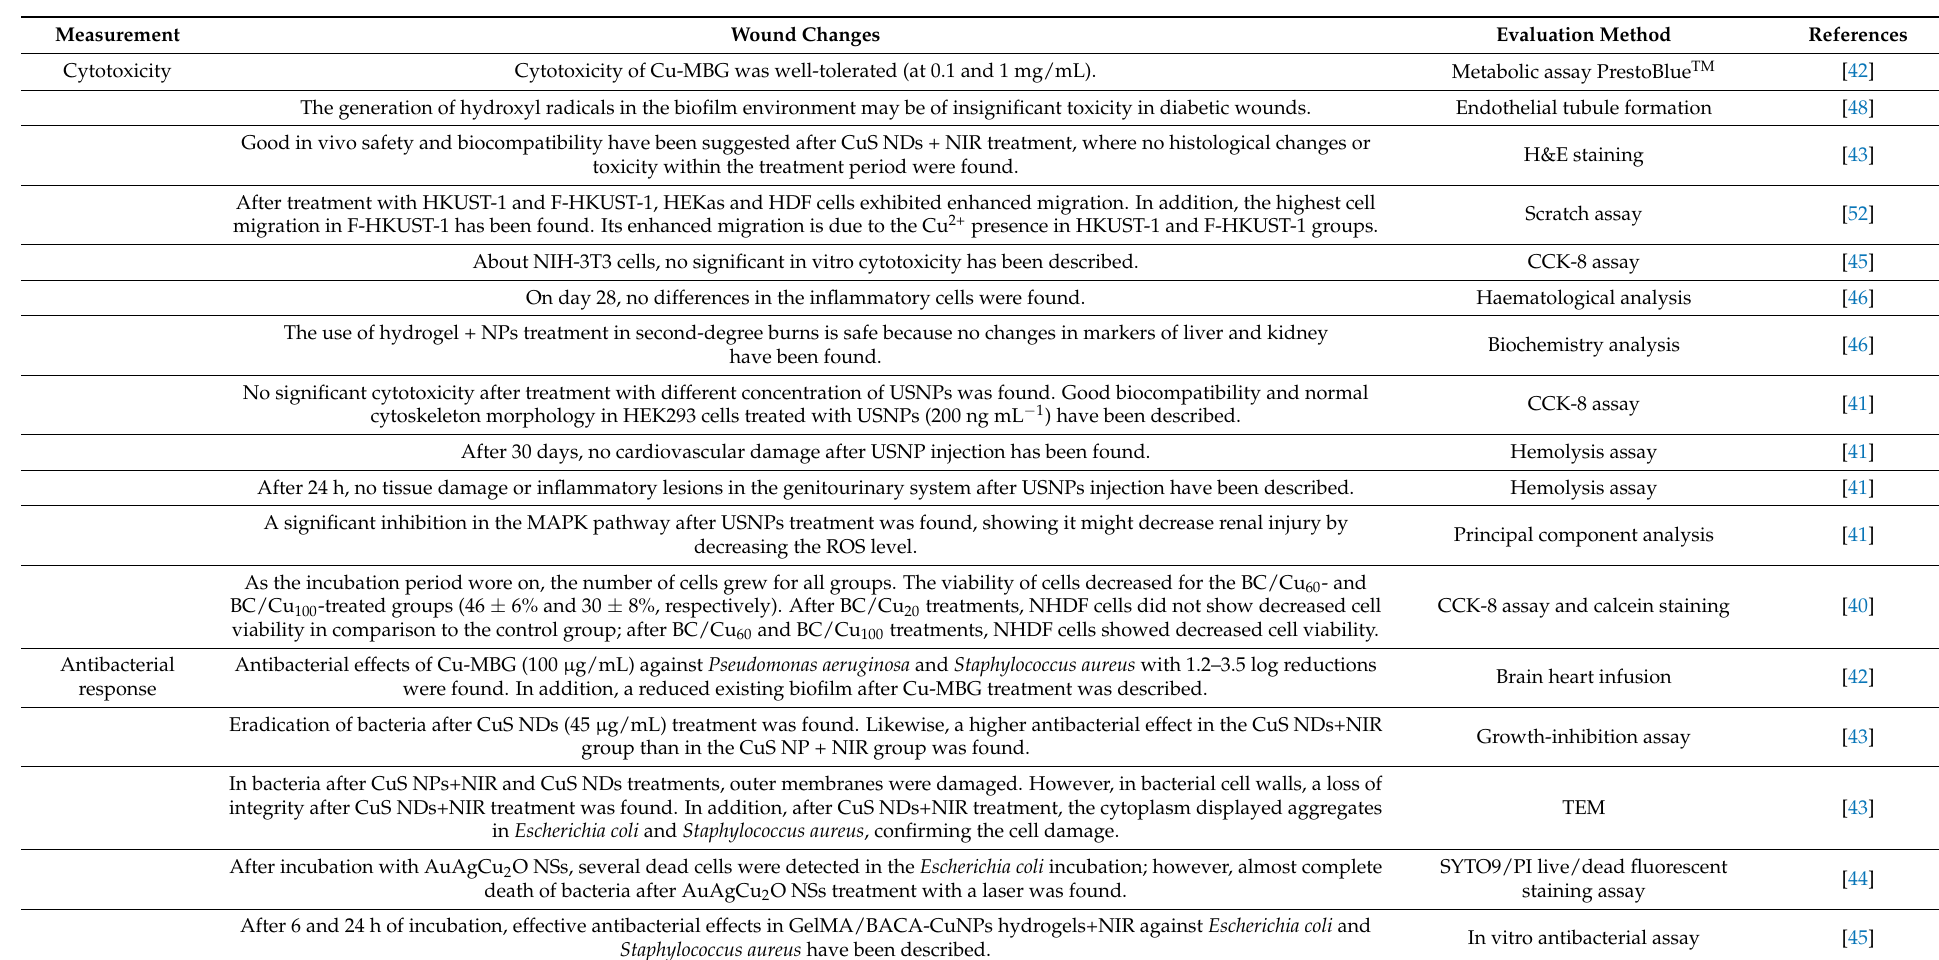
Table 2. Variables involved in effectiveness of copper nanoparticles in the healing process of chronic wounds in in vivo and in vitro studies.